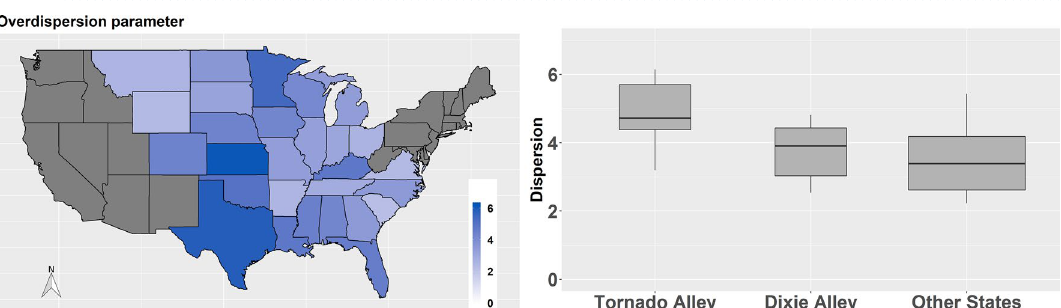
Figure 5. Map of median overdispersion parameter from the negative binomial distribution along with its group-level distribution in Tornado Alley , Dixie Alley and Other States . (The map is created in R version 3.5.2 using the ggplot2 package 32 , https ://CRAN.R-proje ct.org/packa ge=ggplo